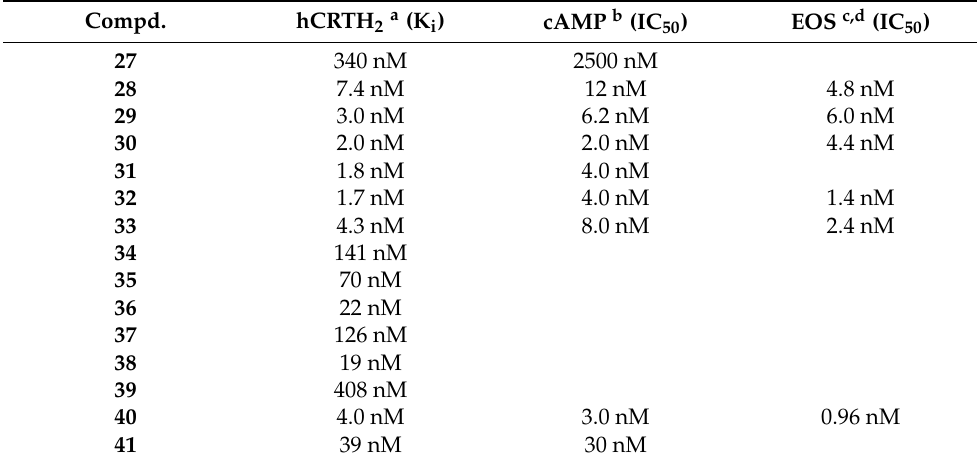
Table 1. Binding affinity and functional antagonism on hCRTH 2 for preliminary aryl amides and structure–activity relationship (SAR) on the amide linker (values were obtained from [73]). Compd.